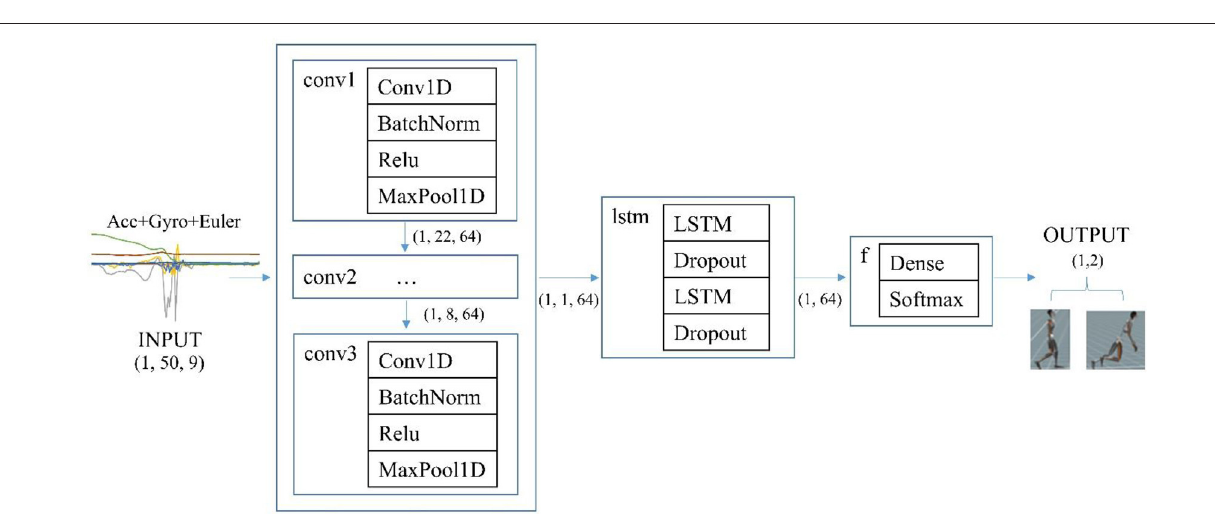
FIGURE 7 | The architecture of the deep learning model